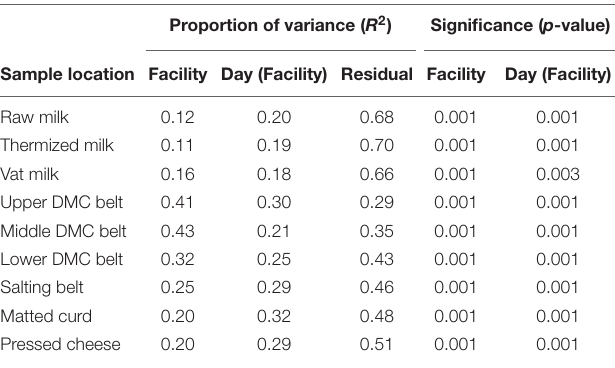
TABLE 2 | Significance and explained variance of facility and production day nested within facility as determined by PERMANOVA of the Aitchison’s